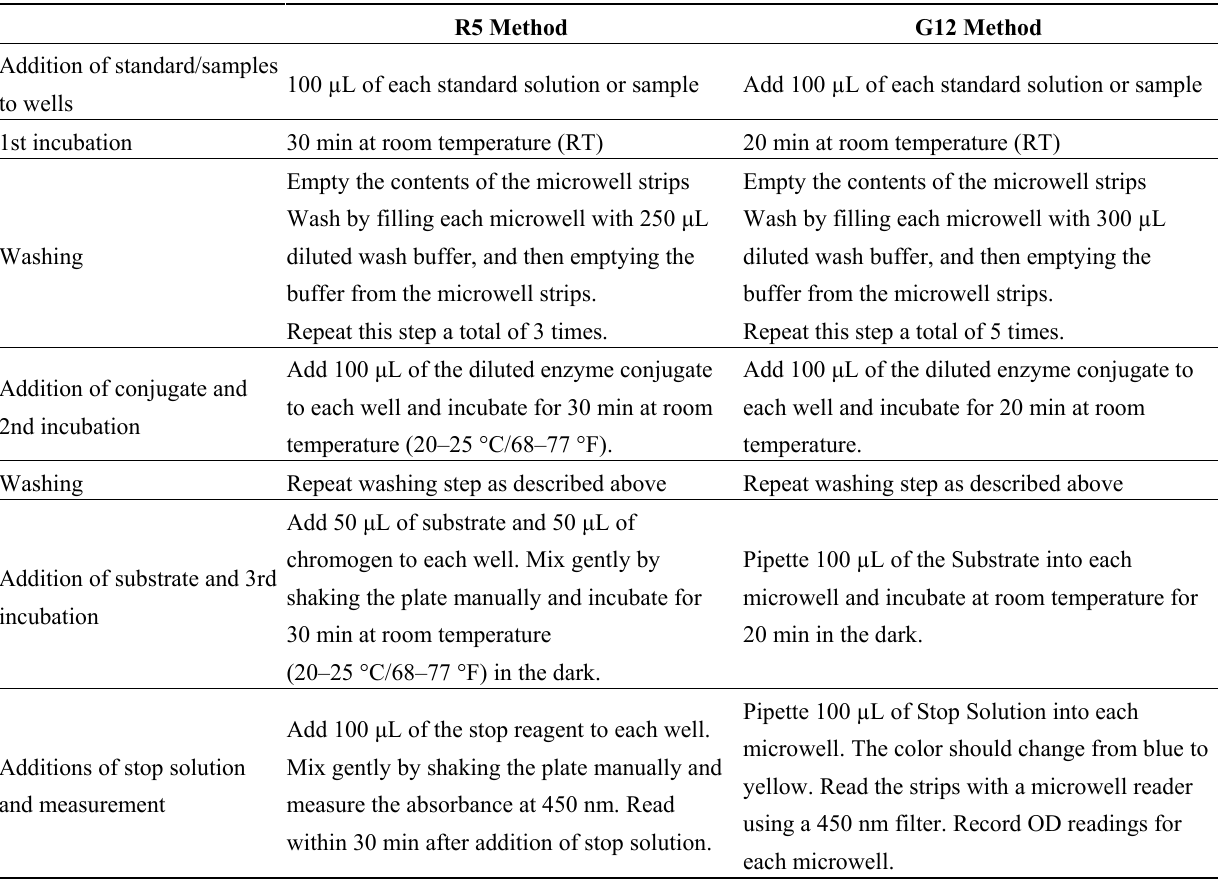
Table 1. Comparison of the two different assay procedures. R5 Method G12